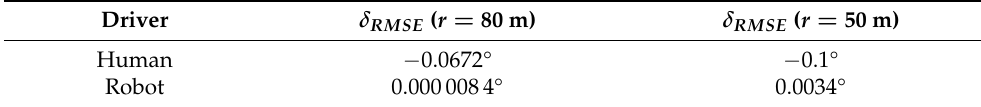
Table 7. RMSE from the nominal steering angle δ in the driven circles.